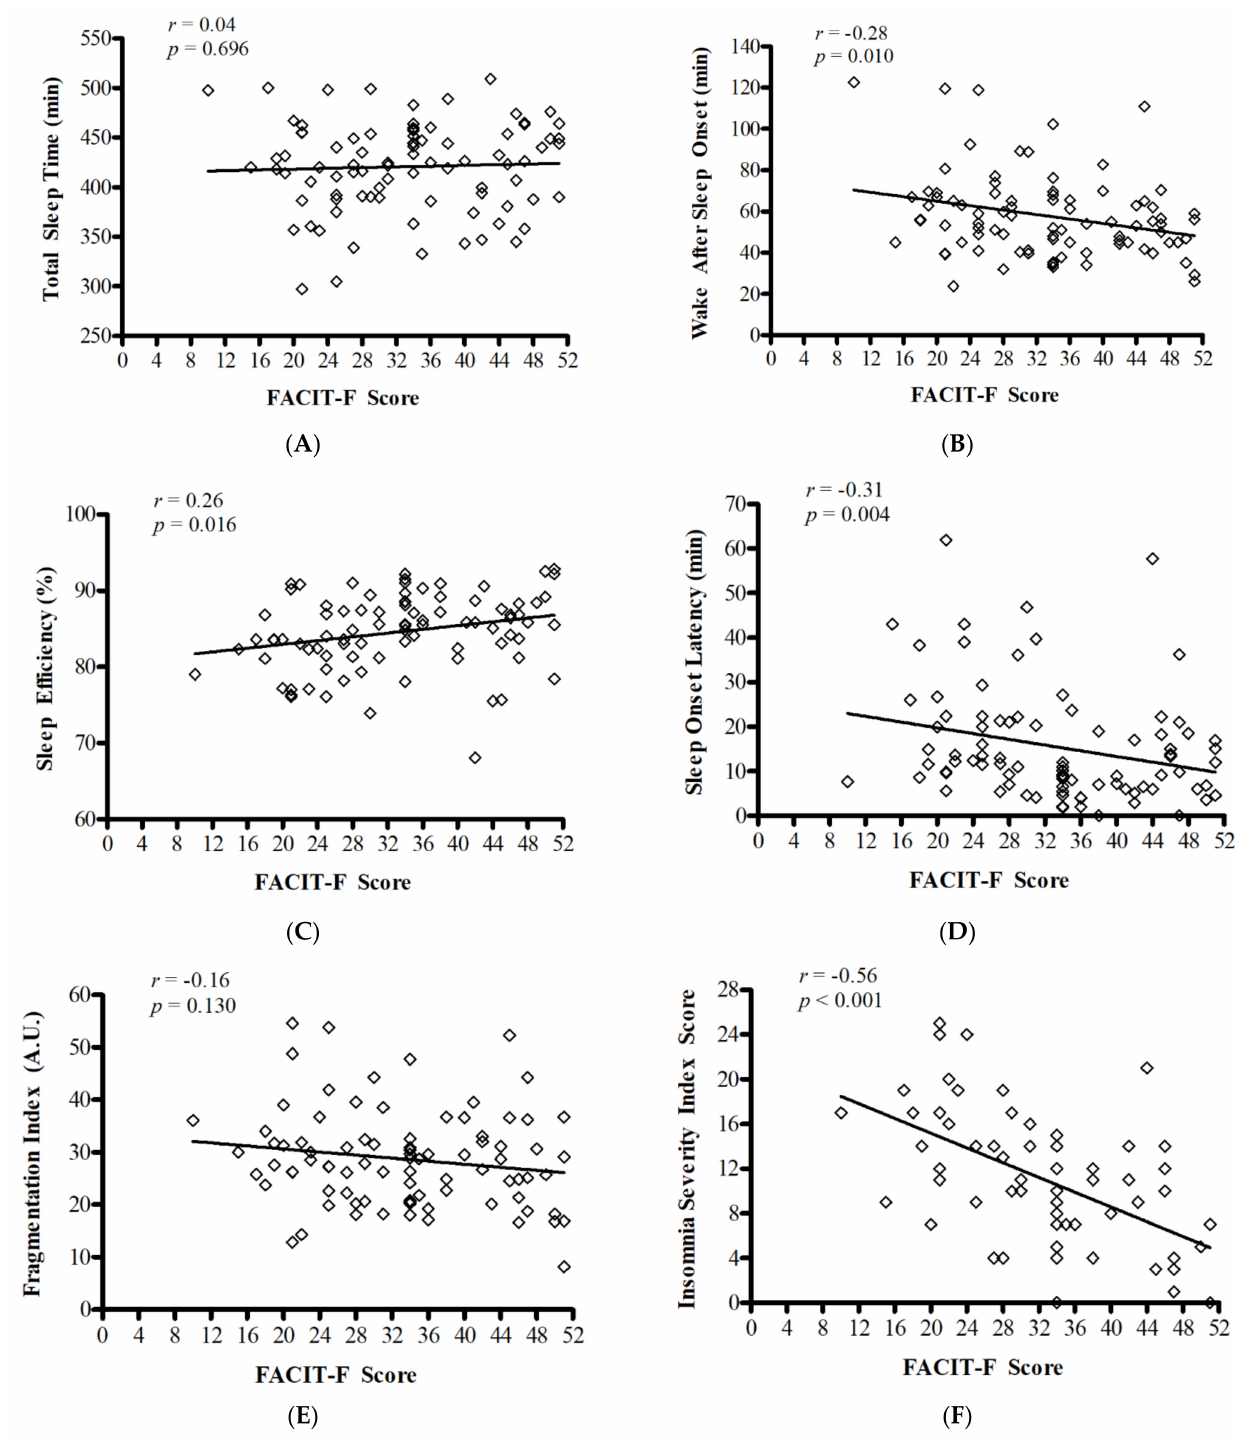
Figure 1. Correlations between actigraphy-derived sleep parameters and Functional Assessment of Chronic Illness Therapy– Fatigue (FACIT-F) score (panels A – E ), and the correlation between the Insomnia Severity Index score and FACIT-F (panel F ). A lower FACIT-F score indicates higher fatigue